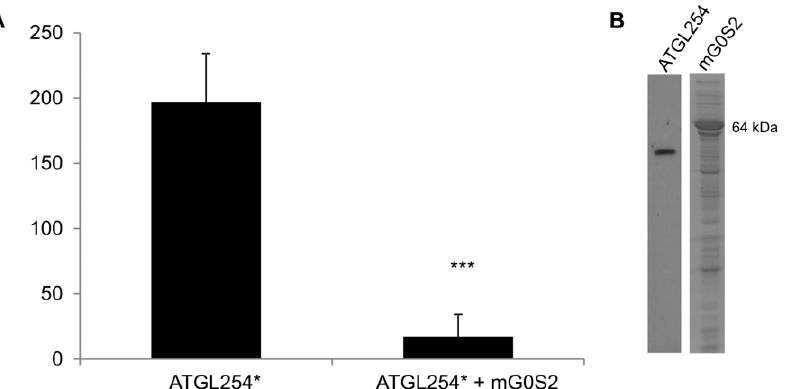
Figure 5. Minimal active fragment of ATGL can be inhibited by G0S2. A. ATGL254 was expressed in E. coli , lysates prepared, and TG hydrolase activity assay performed in the presence of purified CGI-58 (*), without and with addition of mG0S2 as described in Figure 2. Data are presented as mean + SD and representative for three independent experiments, each performed in triplicates. *** indicate statistical significant differences as determined by unpaired Student’s t -test (two-tailed), p . 0.001. B. Western Blotting analysis of ATGL254 expression and SDS-PAGE gel confirming expression of mG0S2 in bacterial lysate.